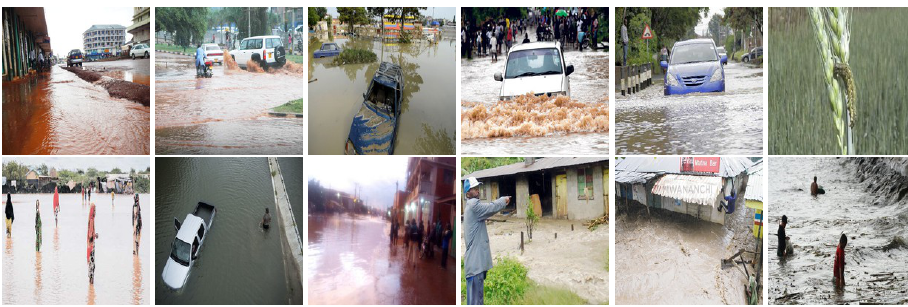
Figure 9. Few of the correctly retrieved images by VRBagged-Net for the INTD